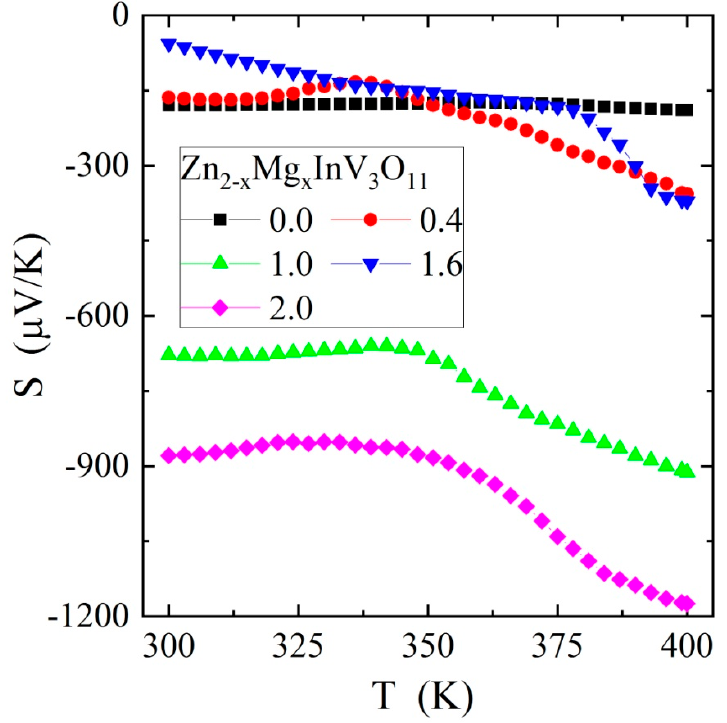
Figure 4. Thermoelectric power S vs. temperature T of Zn 2 − x Mg x InV 3 O 11 .